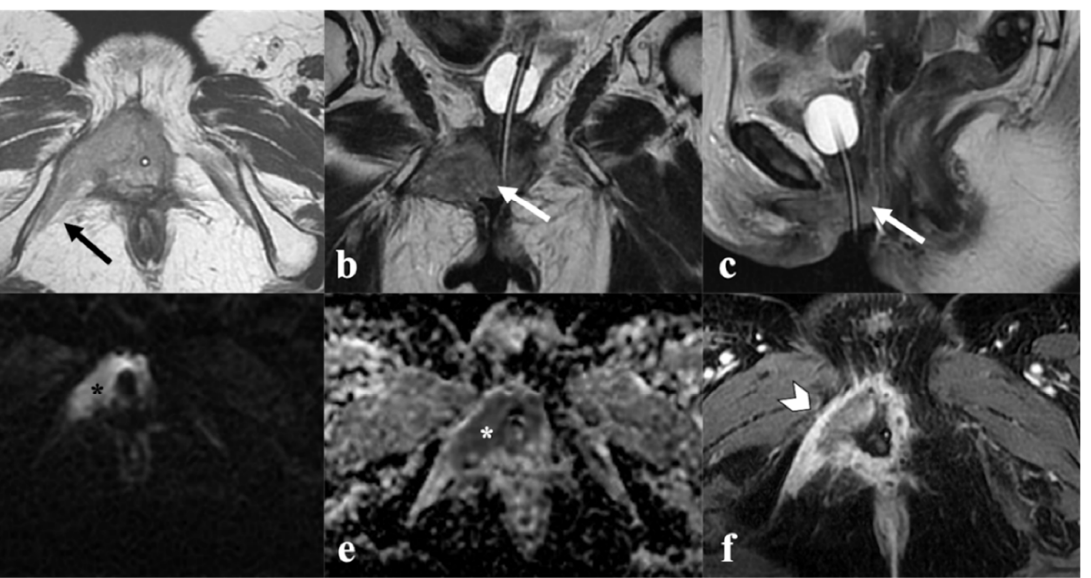
Figure 4. Recurrence on mons pubis. A 68-year-old patient previously treated with anterior vulvectomy for squamous cell carcinoma of the clitoris, presents 7 months later with intermediate T2 signal intensity mass in the subcutaneous tissue of mons pubic (( a , b )—white arrow) showing enhancement in post-contrast T1 coronal image (( c )—white arrowhead), consistent with recurrence. Inguinal node recurrence occurs in 22% of cases, most frequently in patients with initial lymph node involvement [36]. In patients previously submitted to surgery, recurrence may rarely occur in the skin bridges located between the prior vulva and the ipsilateral inguinal region (Figure 5).